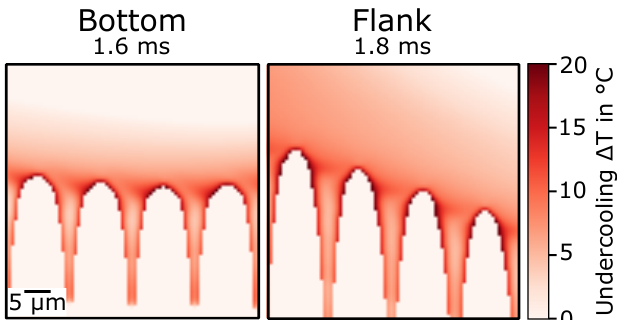
Figure 9. Undercooling after remelting at two locations in melt pool (compare Figure 7) at ( left ) melt-pool bottom at 1.6ms and at ( right ) flanks at 1.8ms.